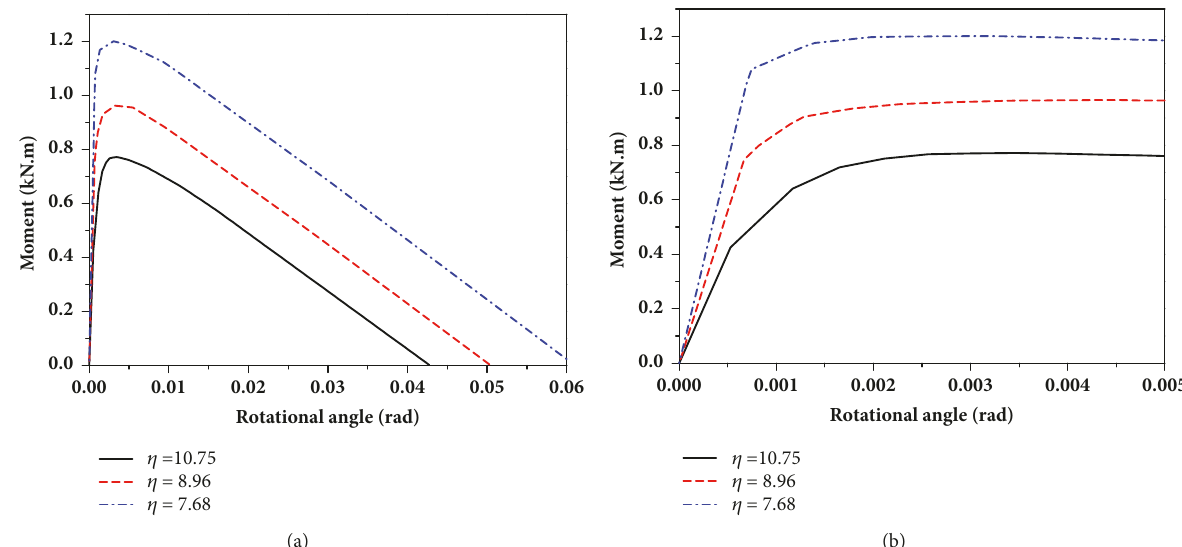
 =10.75  = 8.96  = 7.68 Figure 7: Moment-rotation curves with different column diameter: (a) global view; (b) local view.